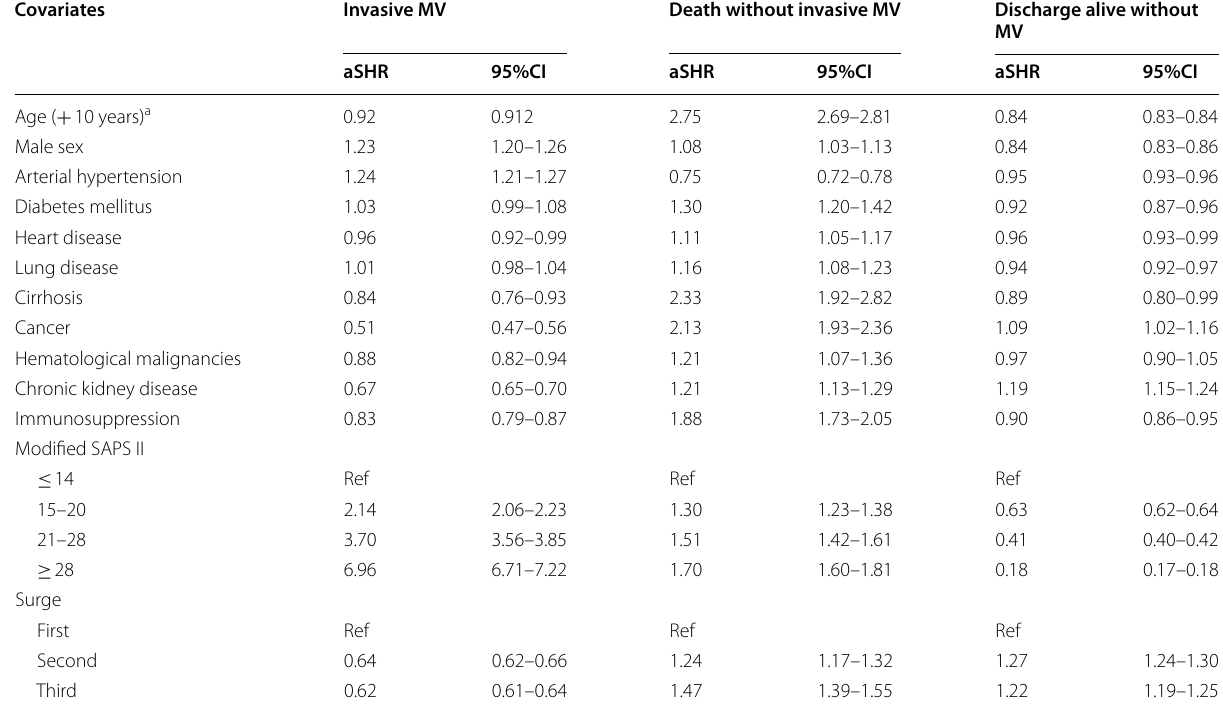
aSHR, adjusted sub-hazard ratio; CI, confidence interval; MV, mechanical ventilation; SAPS, simplified acute physiology score a The aSHR of age corresponds to SHR for each 10 years in more